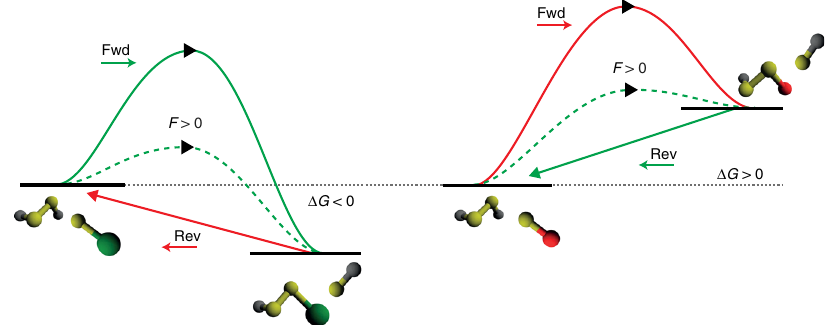
Fig. 4 Mechanical force deforms the reaction energy landscape and modulates the reversibility of the reaction. Schematics of the 1D energy landscapes highlighting how the application of mechanical force to an individual protein disul fi de in the presence of chemically distinct small thiolates induces disul fi de bond rupture and governs the reaction reversibility. Using a thiol nucleophile that renders the disul fi de bond cleavage reaction thermodynamically spontaneous ( Δ G < 0), mechanical force will lower the main energy barrier (dashed arrow), giving rise to a low free energy mixed-disul fi de. Consequently, the reverse reaction (entailing the S N 2 reattack of the mixed disul fi de bond by the neighboring protein reduced thiolate) will not be favorable, making the overall net reaction irreversible (red solid arrow). By contrast, mechanical force can trigger a thermodynamically un-favored reaction ( Δ G > 0) by also signi fi cantly lowering its activation energy (dashed arrow). In this case, the resulting mixed disul fi de bond has higher energy than the initial reactants. Hence, upon force release, the reformation of the initial disul fi de bond becomes suddenly spontaneous, rendering the overall reaction reversible (green solid